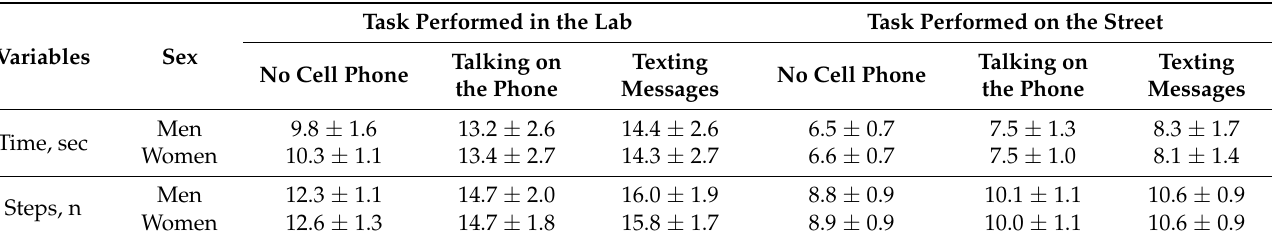
Table 2. Walking performance of the